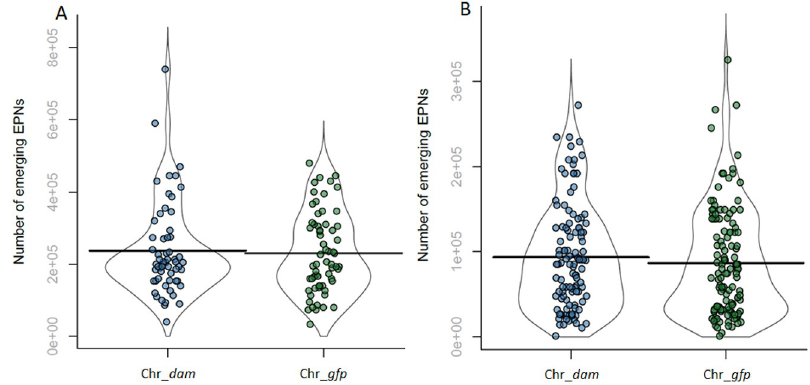
value = 0.991). (B) Emerging IJs from S . littoralis larvae cadaver for each strain. The amount of IJs exiting from larvae cadaver were not significantly different (Wilcoxon, p-value = 0.31).